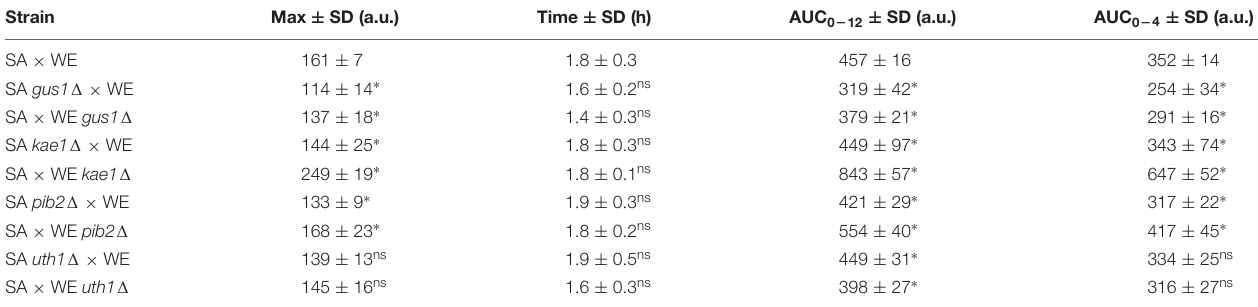
TABLE 3 | Parameters associated with the luciferase expression in the reciprocal hemizygous strains. Strain Max ± SD (a.u.) Time ± SD (h) AUC 0 − 12 ± SD